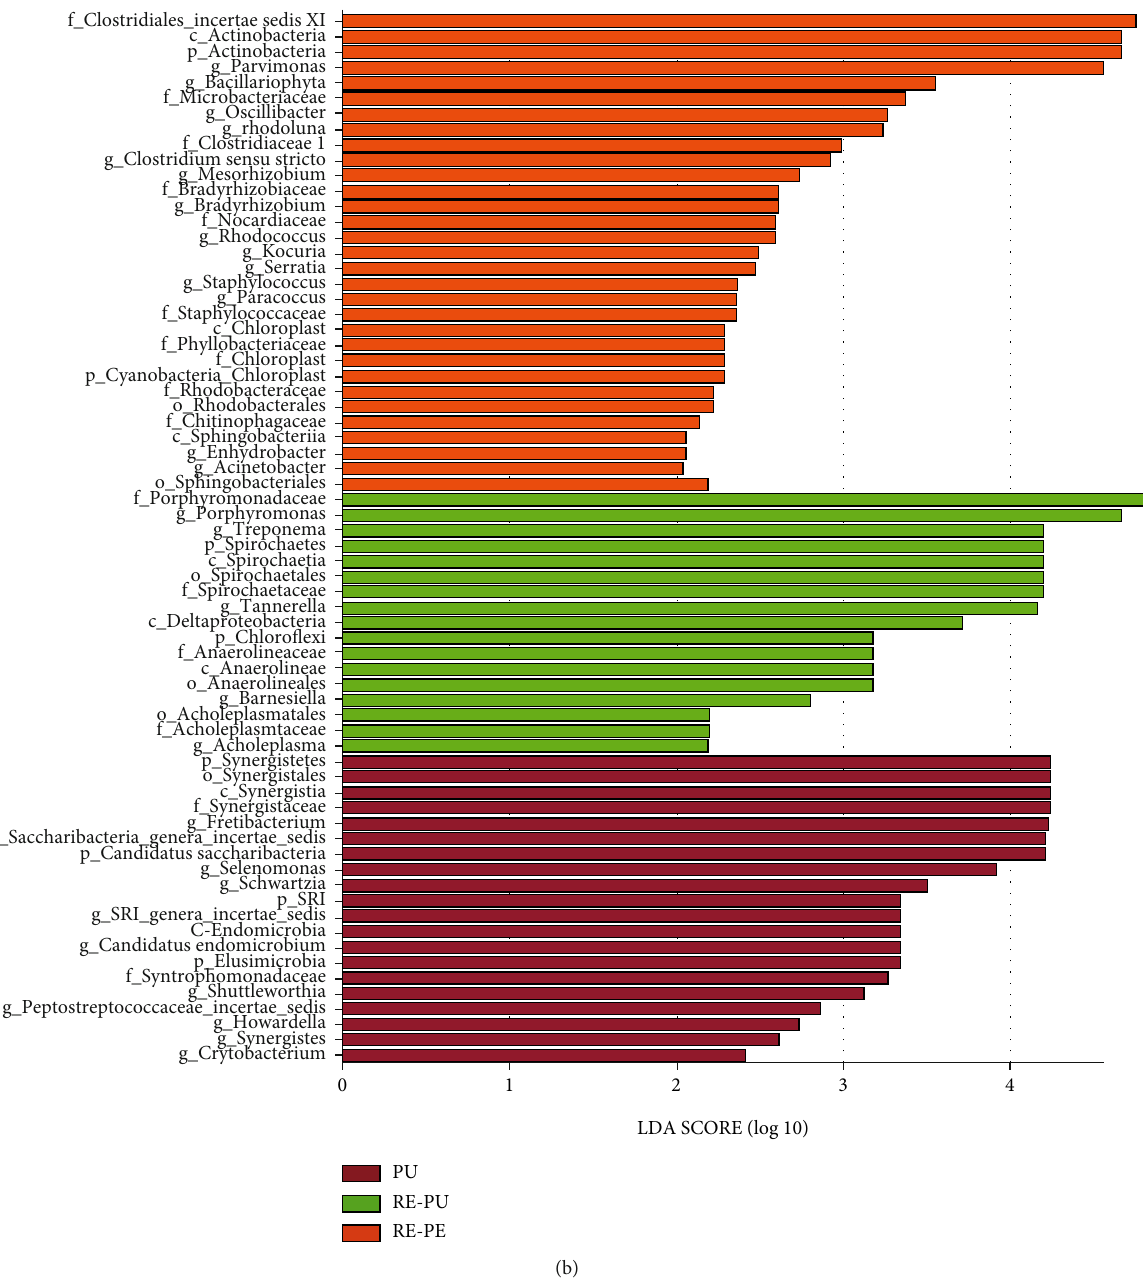
Figure 2: The linear discriminant analysis (LDA) e ff ect size (LEfSe) pro fi les of PE, RE-PE, and RE-PU. (a) Cladograms indicating the phylogenetic distribution of bacterial lineages among 3 groups. The phylum, class, order, family, and genus levels are listed in order from inside to outside of the cladogram, and the labels for levels of order, family, and genus are abbreviated by a single letter. (b) LDA along with e ff ect size measurements was applied to present the enriched bacterial genera of each